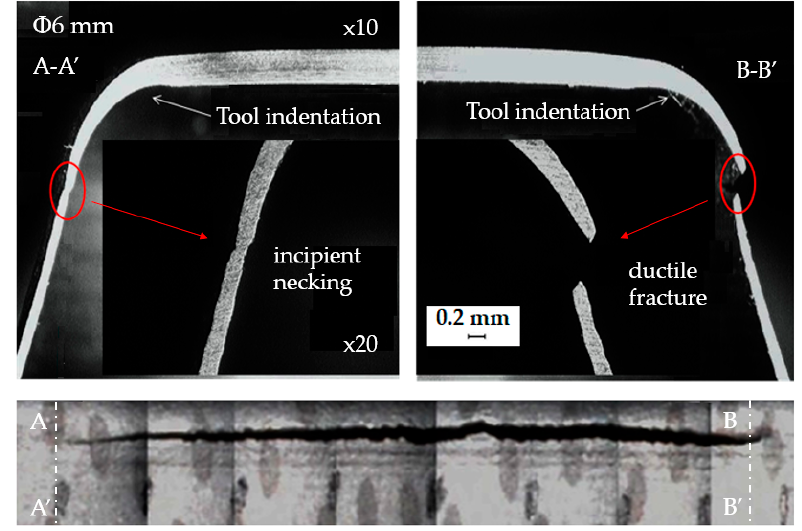
Figure 8. Fractography of the fracture zone at 2 sections for a tool diameter of Φ 6 mm. Section A-A’ corresponds to the crack initiation whereas section B-B’ is placed close to its end.